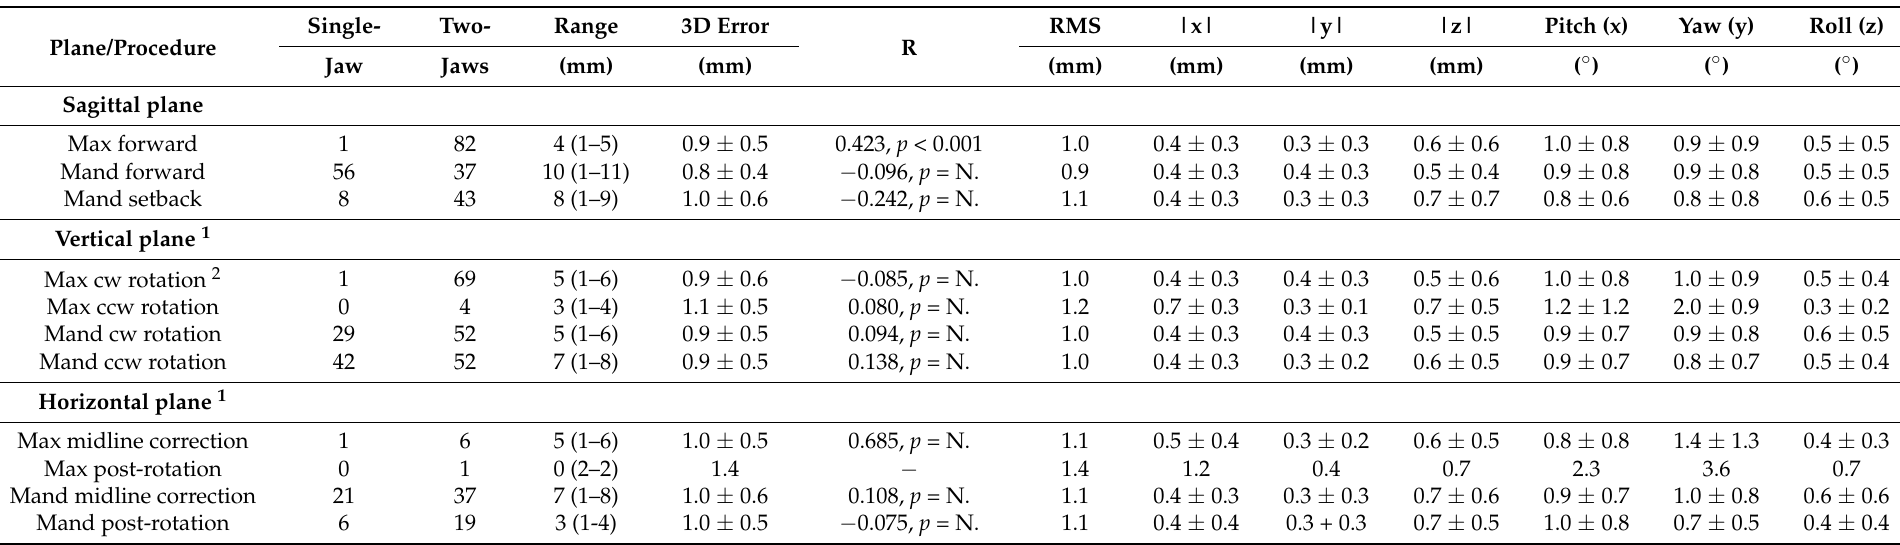
Table 2. Surgical procedures and error measurements grouped by spatial